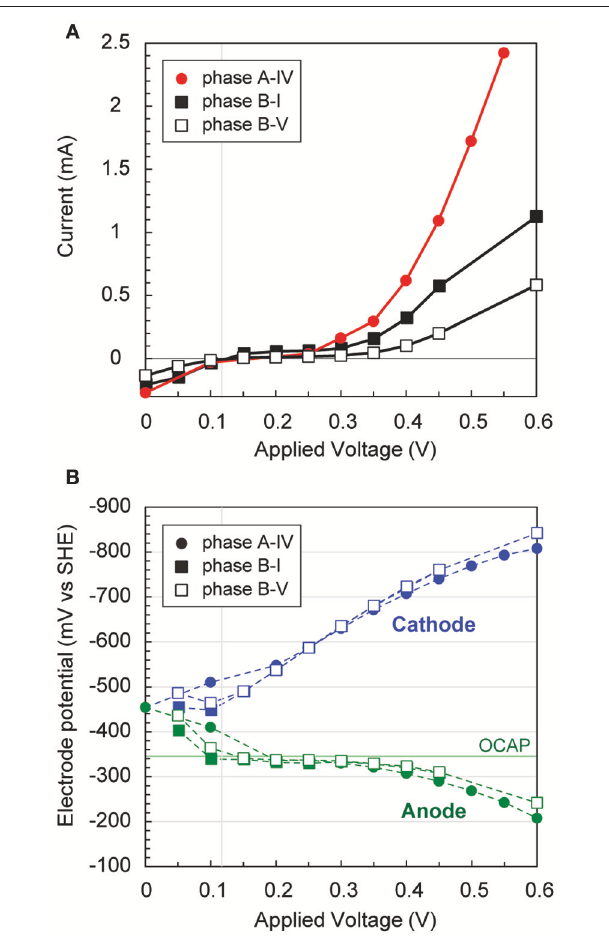
FIGURE 3 | Polarization curves via potential step voltammetry in the electromethanogenic BESs. (A) During potential step voltammetry, current generation after 5min (for reactor a) or 15min (for reactor b) with applying different voltages is plotted for different phases of the BESs (box for labels). (B) Anodic (blue dashed lines and blue labels) and cathodic (green dashed lines and green labels) potentials are plotted during the potential step voltammetry. OCAP indicates open circuit anode